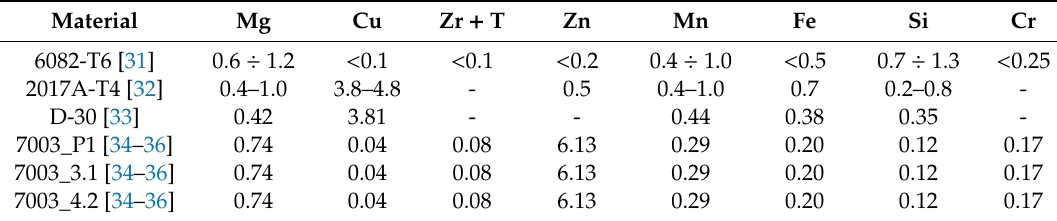
Table 1. Chemical composition of the analyzed materials in % (remainder Al).